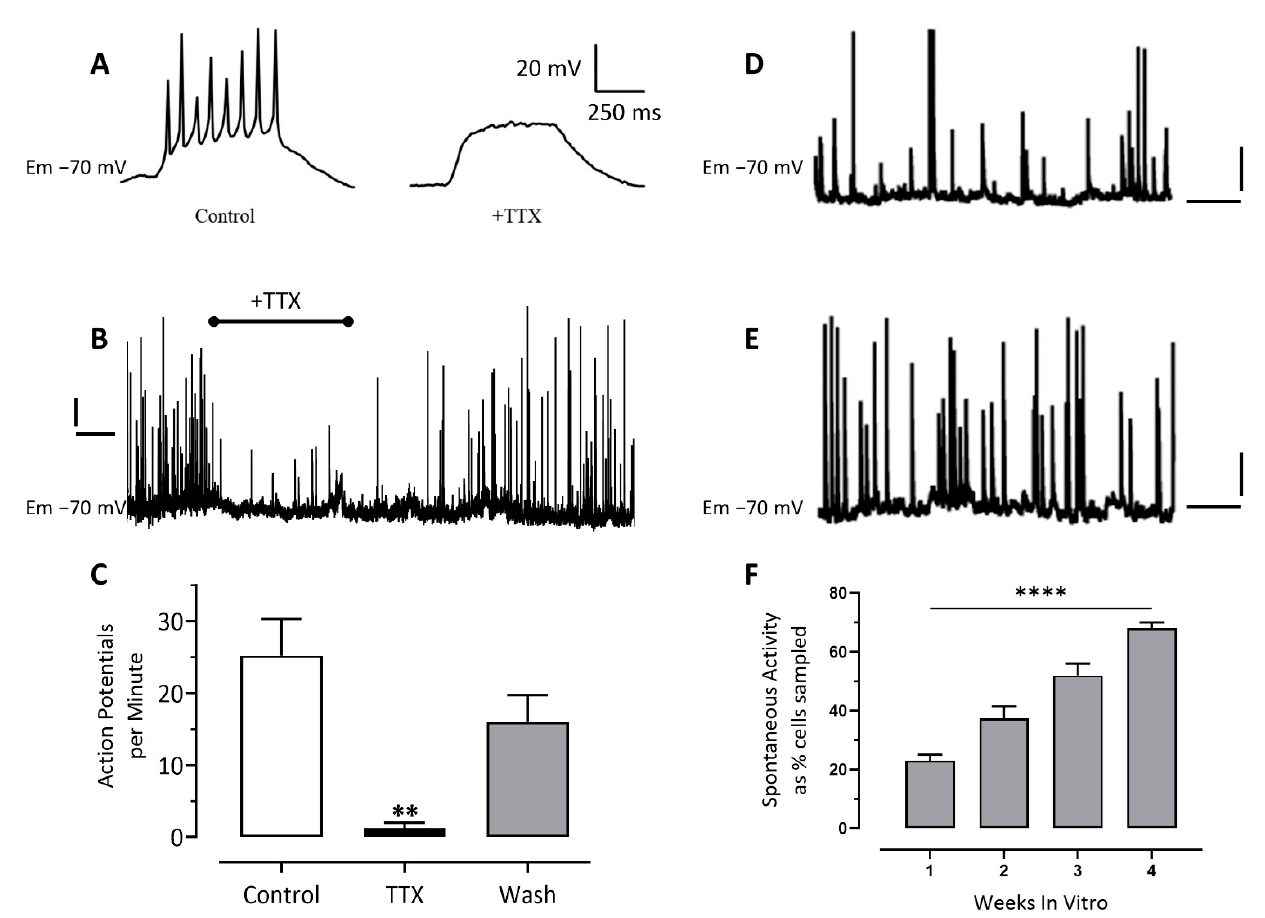
Figure 4. Patch-clamp recordings from iCell neurons show they fire evoked and spontaneous action potentials sensitive to tetrodotoxin (TTX). ( A ) Recording from an iCell neuron (28 days in vitro) held in current clamp at − 70 mV with (0.4–5 s) depolarizing current applied to evoke a train of immature action potentials before and in the presence of TTX (100 nM). ( B ) Recording of spontaneous action potentials before, during and after washout of TTX (100 nM) to the bath solution; the calibration bars are 10 mV and 50 s. ( C ) Histogram summarizing the effect of TTX (100 nM) on the number of spontaneous action potentials per minute recorded from iCells neurons at 10 weeks in vitro. The bars and lines represent the mean ± SEM ( n = 5). ** p ≤ 0.01. ( D ) Spontaneous action potentials recorded from an iCell neuron at 1 week and, ( E ) 4 weeks in vitro (the calibration bars are 20 mV and 10 s for both D and E). ( F ) Histogram showing the percentage of spontaneously active cells sampled significantly increased (**** p ≤ 0.0001) over 1–4 weeks in vitro. The bars and lines represent the mean ± SEM ( n = 12–40 cells per time point).